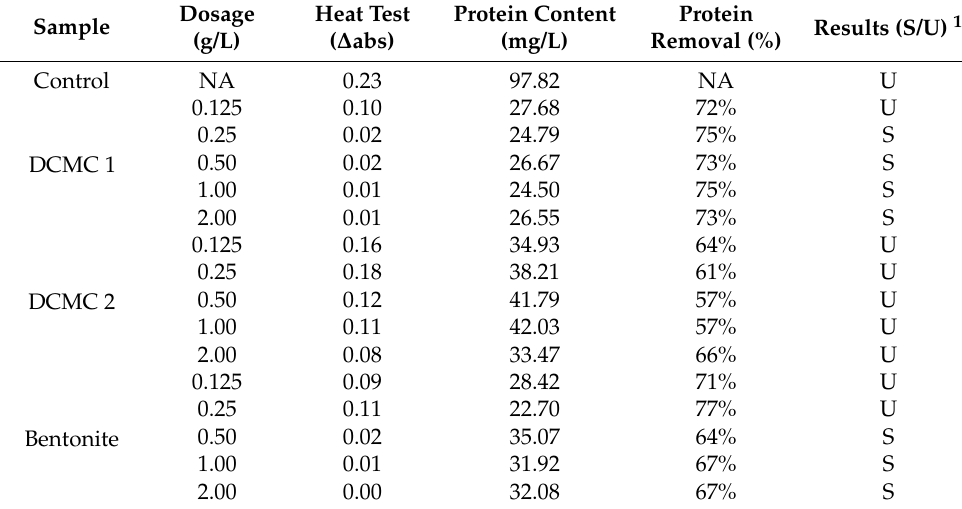
Figure 5. HPLC chromatograms of Primavera wine and the same wine treated with 0.25 g/L of DCMC 1 and 0.5 g/L of bentonite. Table 4. Summary of the protein stability and protein quantification